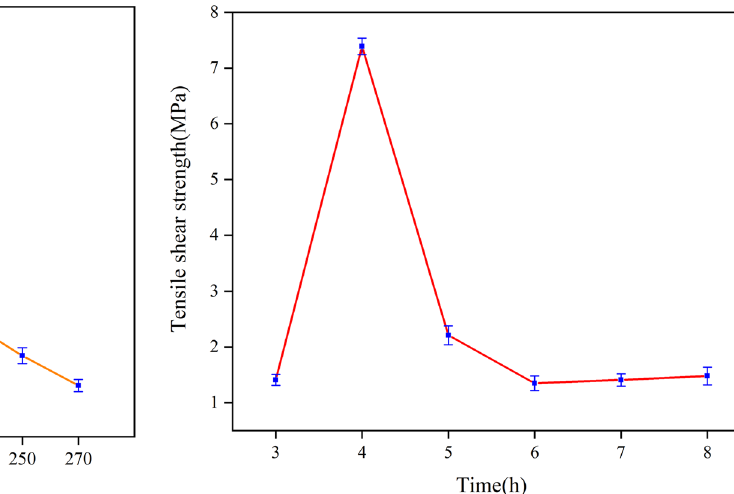
Figure 8: Tensile shear strength of E 2 with di ff erent curing temperatures.